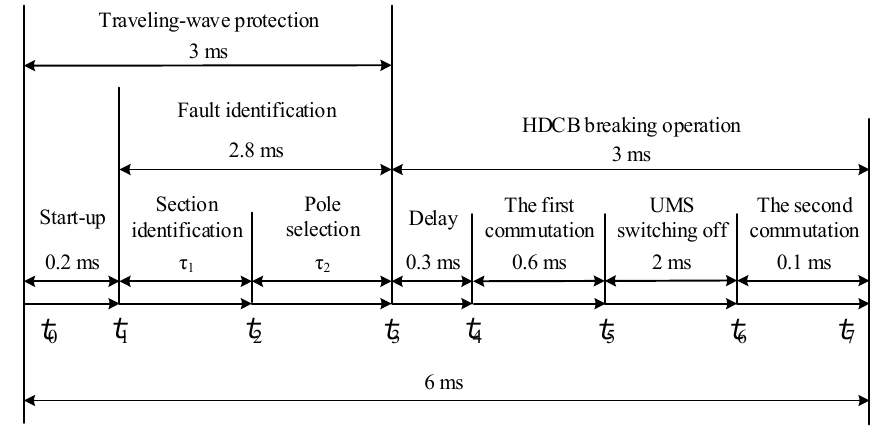
Figure 7. Traditional strategy.